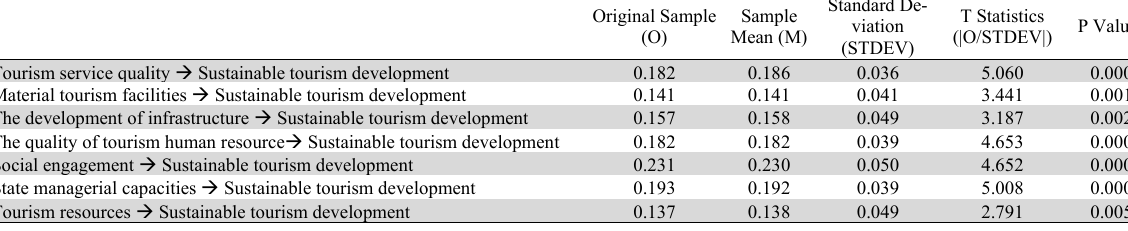
The correlation between influencing factors and sustainable tourism development